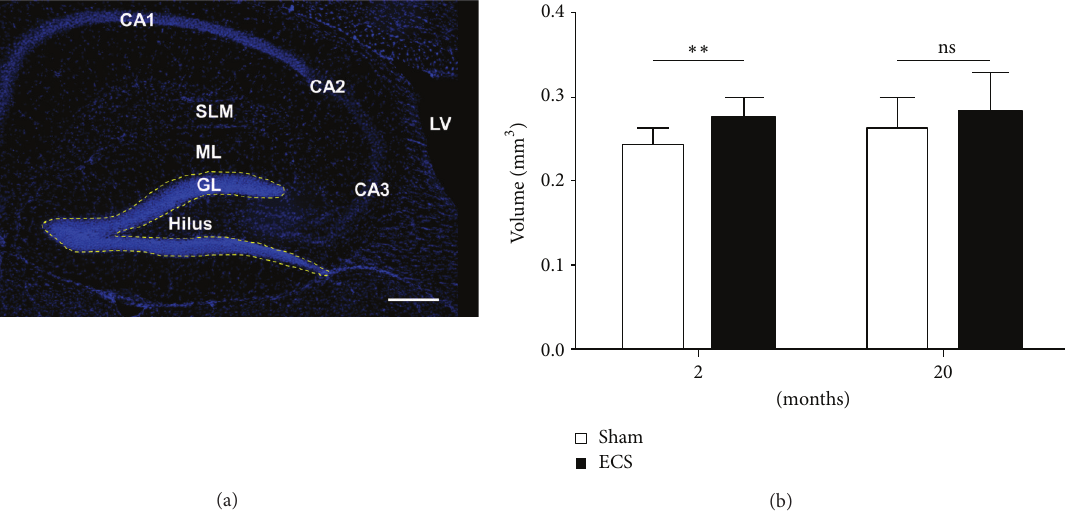
Figure 6: (a) Overview of a murine hippocampus with its substructures cornu ammonis (CA) 1–3, lateral ventricle (LV), stratum lacunosum moleculare (SLM), molecular layer (ML), granular layer (GL), and the hilus. Scale bar: 200 𝜇 m. (b) Volume of the dorsal dentate gyrus of 2- and 20-month-old mice following ECS or sham-treatment. Young mice showed a significant increase of volume after ECS (2 months, 𝑃 = 0.002 ( ∗∗ ); 20 months